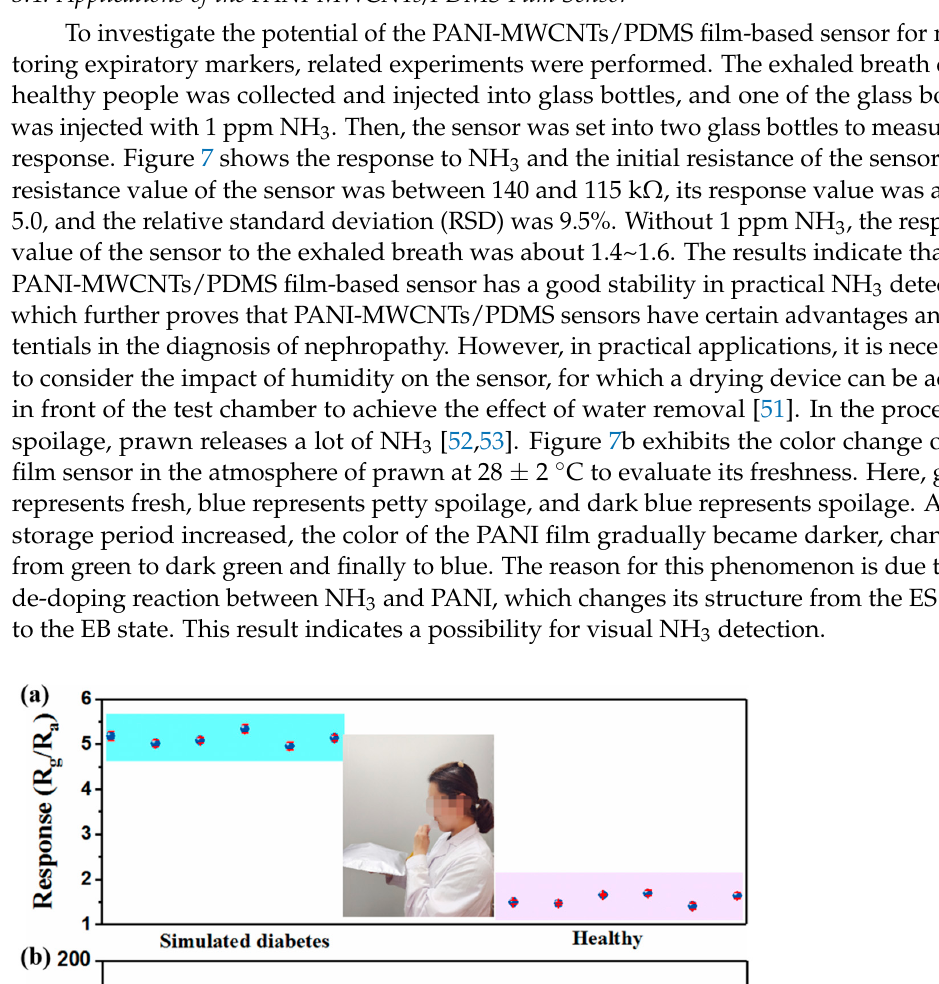
Figure 7. The response of PM2 sensors to exhaled breath of healthy patients and simulated pa- tients with kidney disease ( a ) and the initial resistance of sensor without NH 3 ( b ); changes in the colorimetric sensors at different shrimp placement times ( c ). 4. Conclusions In summary, PANI was grown on MWCNTs/PDMS films via chemical oxidation polymerization. The morphology and structure demonstrated the formation of film mate- rials, and a PANI-MWCNTs/PDMS film-based NH 3 sensor was successfully developed. At room temperature, the response of the film sensor to 40 ppm NH 3 was 11.8 ± 0.2, with a recovery time of 236 s and a detection limit of 10 ppb. The sensor was applied to identify the breath of healthy patients and simulated patients with kidney disease, and the results show that the sensor has a good ability to identify simulated samples. Meanwhile, a visu- alized thin-film sensor with a sensitive color change to NH 3 was developed. Then, the sensitivity mechanism was systematically explained. This work prepared a flexible sensor